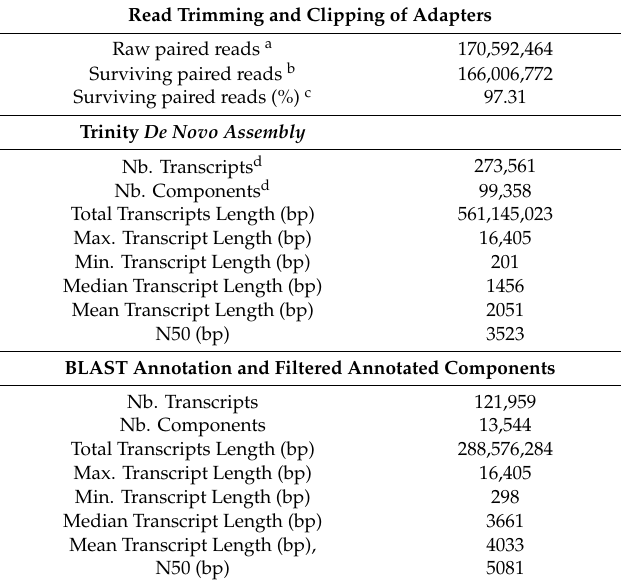
Table 1. Result of Illumina sequencing output and assembly for Armillaria sinapina.